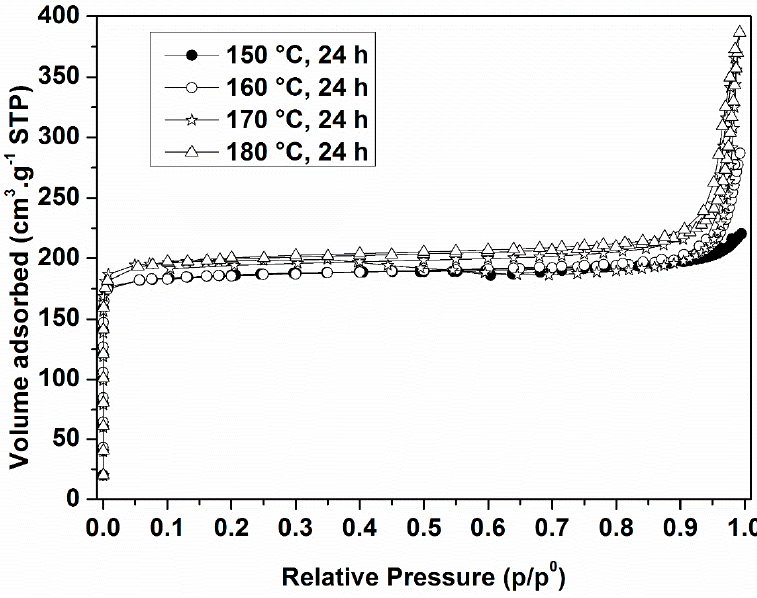
Figure 5. N 2 adsorption isotherms of the calcined samples after a hydrothermal treatment of 24 h at 150 °C, 160 °C, 170 °C and 180 °C.